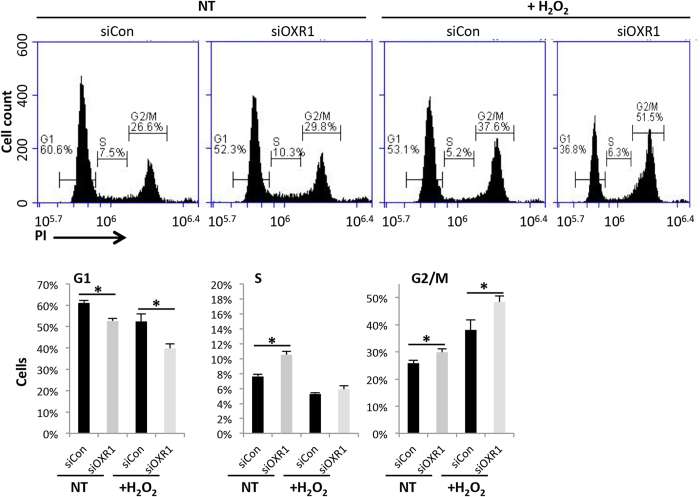
HOXR1 depletion caused cell cycle arrest in G2/M phase.The proportion of cells decreased in G1, but increased in G2/M phase in hOXR1-depleted cells (siOXR1) as compared to control (siCon). Upper panel: one representative set of flow cytometry data. The HeLa cells were exposed to 0.25 mM H2O2 for 1 h or non-treated (NT), recovered in normal medium for 24 h, fixed, stained by propidium iodide (PI) and subjected to flow cytometry. Bottom panel: Data quantification, n = 4. *p < 0.01.